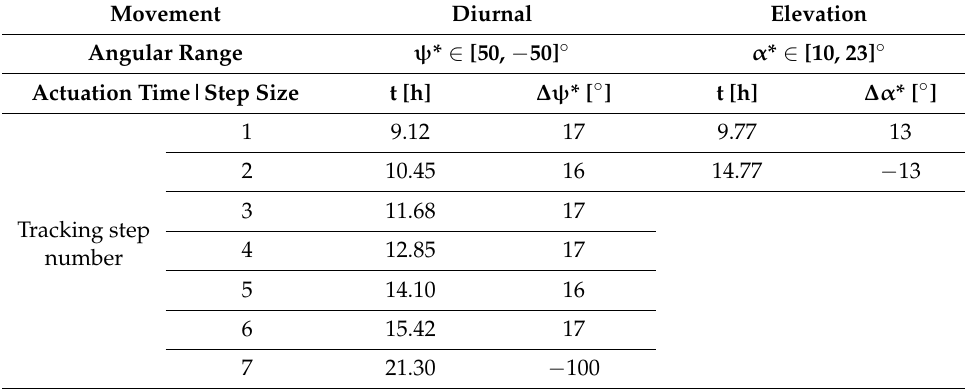
Table 9. Tracking program